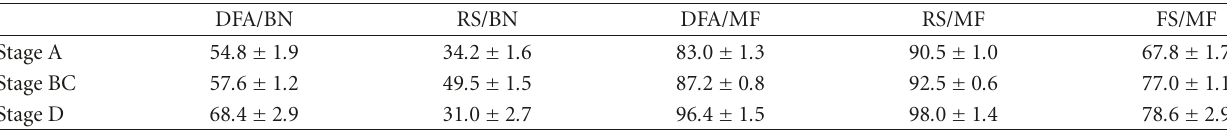
Table 6: Average percentage of correctly classified testing signals coming from stainless-steel samples in di ff erent degradation stages. Classifiers employed detrended-fluctuation (DFA), Hurst (RS), or Fourier spectral (FS) analyses on either Barkhausen noise (BN) or magnetic flux